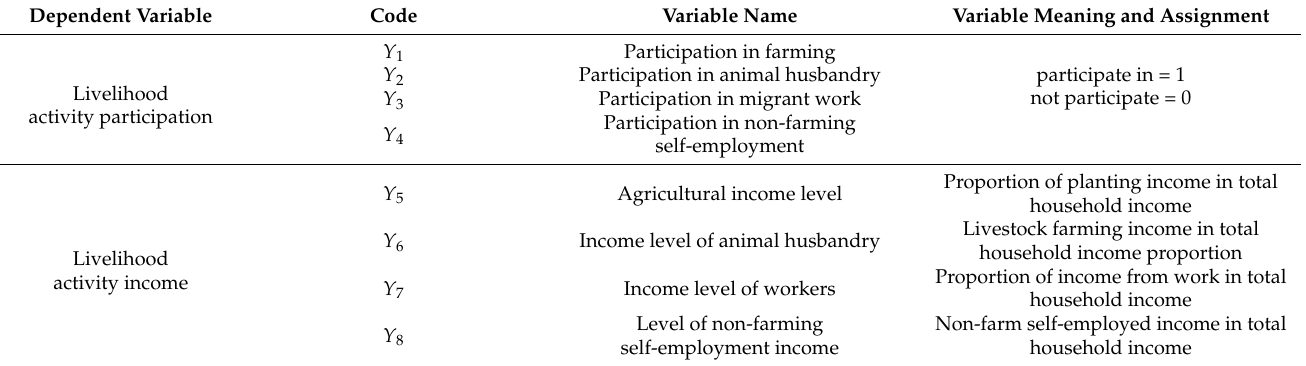
Table 1. Dependent variables used in the models and their